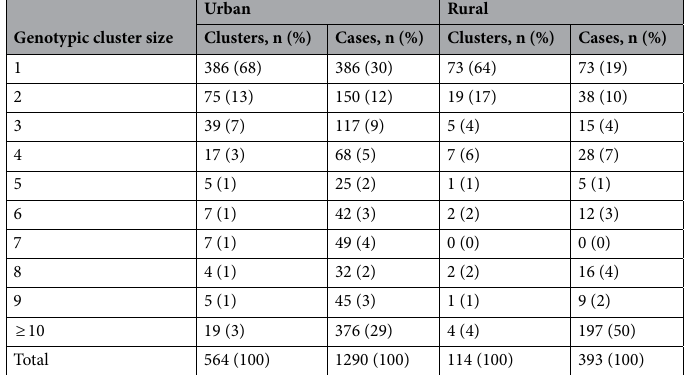
Table 1. Genotypic cluster and case distributions, by population.